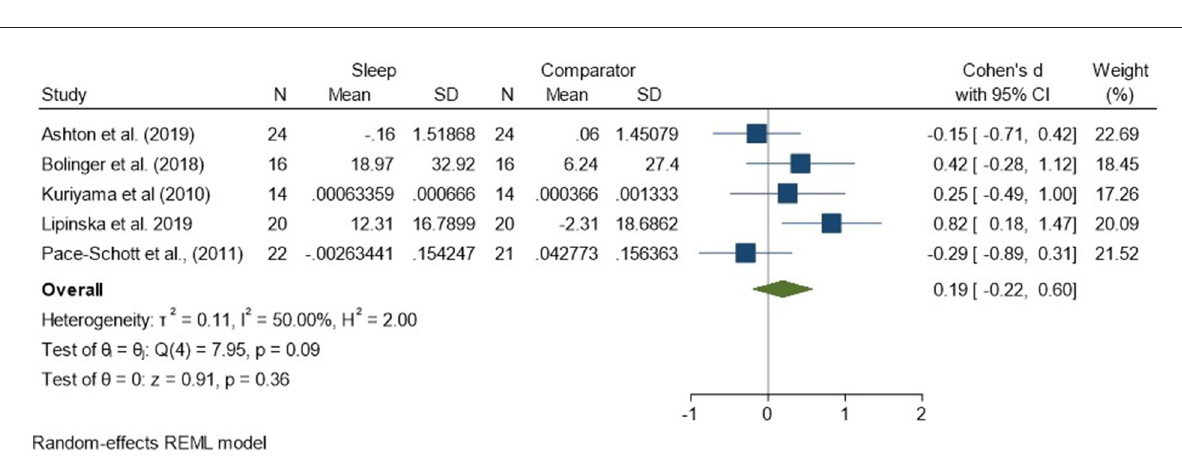
0.39) that was not statistically significant ( p = 0.76; I 2 = 84%; see Figure